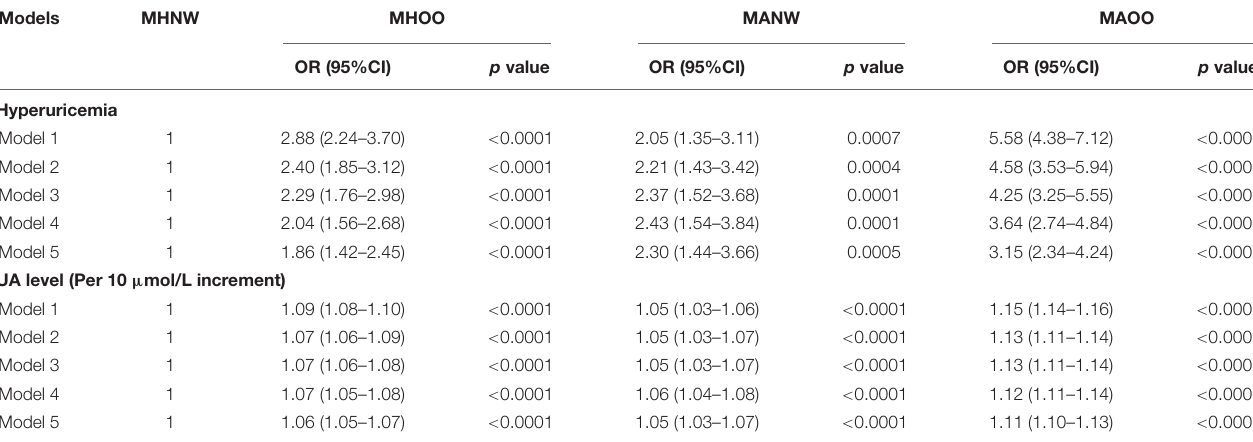
FIGURE 1 | The proportion of obesity metabolic phenotypes among the subjects with hyperuricemia and normal UA levels. Panels (A–C) show the proportion differences of various obesity metabolic phenotypes in hyperuricemia group and normouricemic group in all subjects, men and women, respectively. Differences in the proportion of obesity metabolic phenotypes were analyzed by Chi-square test. TABLE 2 | Multivariable logistic regression analysis of the association between hyperuricemia and obesity metabolic phenotypes.